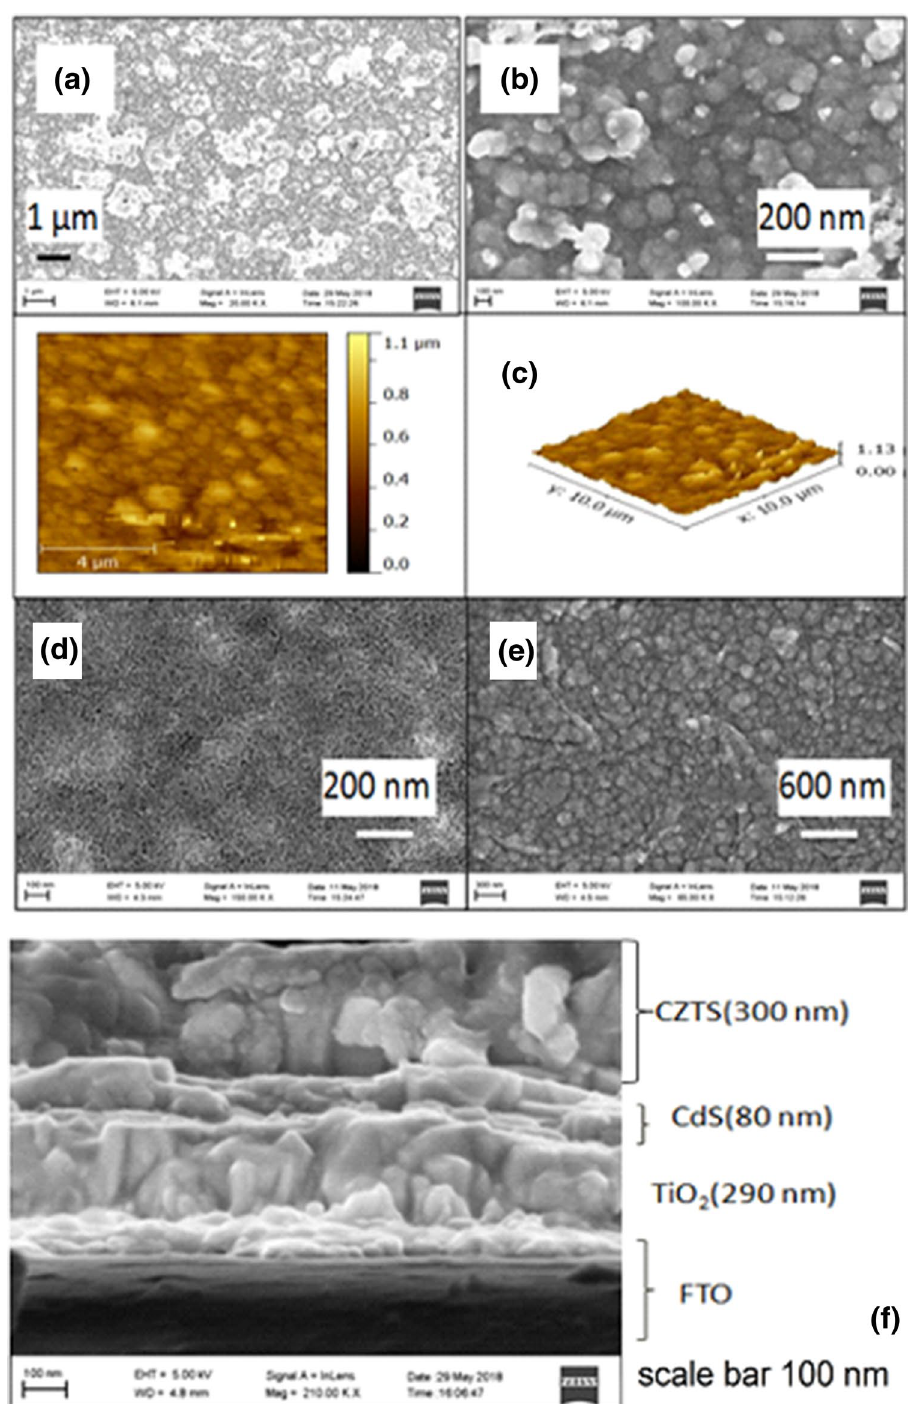
Fig. 3 a and b FESEM micro- graphs of CZTS film deposited on glass substrate. c AFM image of CZTS film. d FESEM image of c-TiO 2 film. e FESEM image of CdS film coated over c-TiO 2 layer. f FESEM micro- graph of cross section of P–N junction with structure glass/ FTO/TiO 2